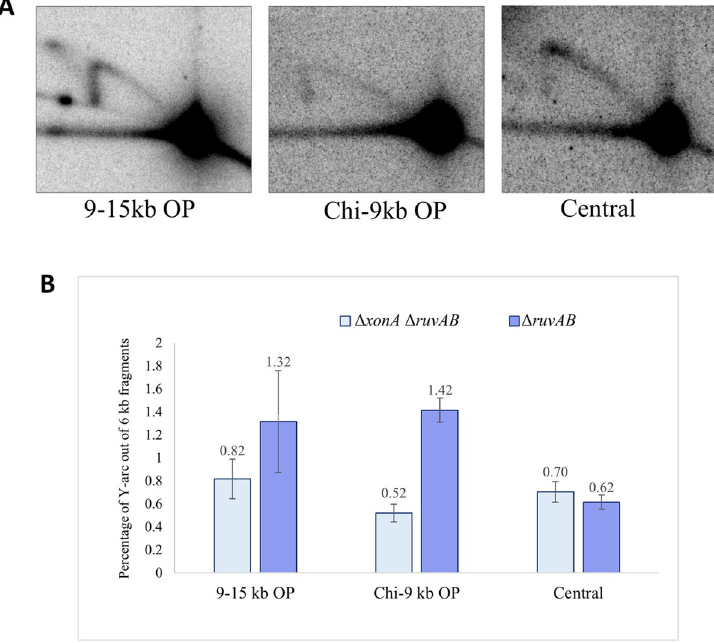
Fig 7. Distribution of repair forks across the central fragment, the Chi-9kb fragment and 9-15kb fragments on the origin-proximal side of the DSB isolated from Δ ruvAB single mutant and Δ xonA Δ ruvAB double mutant strains grown in presence of arabinose. A) 2-D gels of the non-crosslinked 9-15kb OP, Chi-9kb OP and central fragments for Δ xonA Δ ruvAB strains containing the palindrome, grown in the presence of 0.2% arabinose for 60 minutes. B) Quantification of the repair forks generated in the non-crosslinked DNA samples represented as the percentage of DNA in the Y-arc out of the total 6kb DNA fragments. OP and OD mean origin-proximal and origin-distal sides. Error bars represent the standard error of the mean where n = 3. The strains used were DL7840 ( Δ xonA Δ ruvAB 9- 15kb OP), DL7839 ( Δ xonA Δ ruvAB Chi-9kb OP), DL7841 ( Δ xonA Δ ruvAB Chi-Chi), DL7259 ( Δ ruvAB , 9-15kb OD), DL7253 ( Δ ruvAB , Chi-9kb OD) and DL7272 ( Δ ruvAB ,